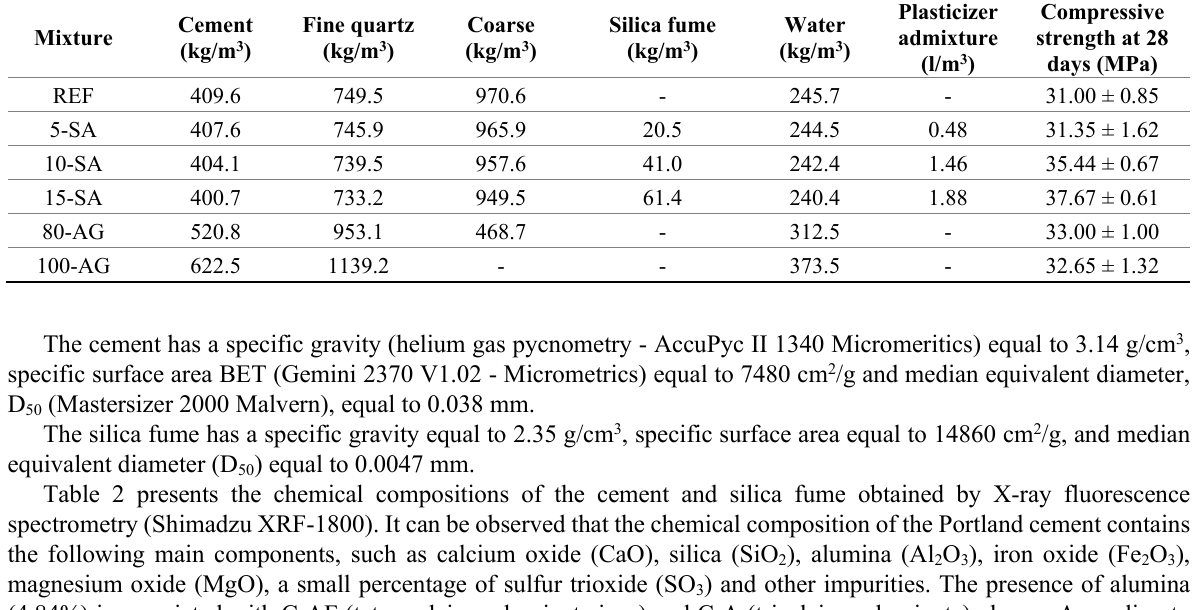
Table 1. Materials consumption per cubic meter of concrete.